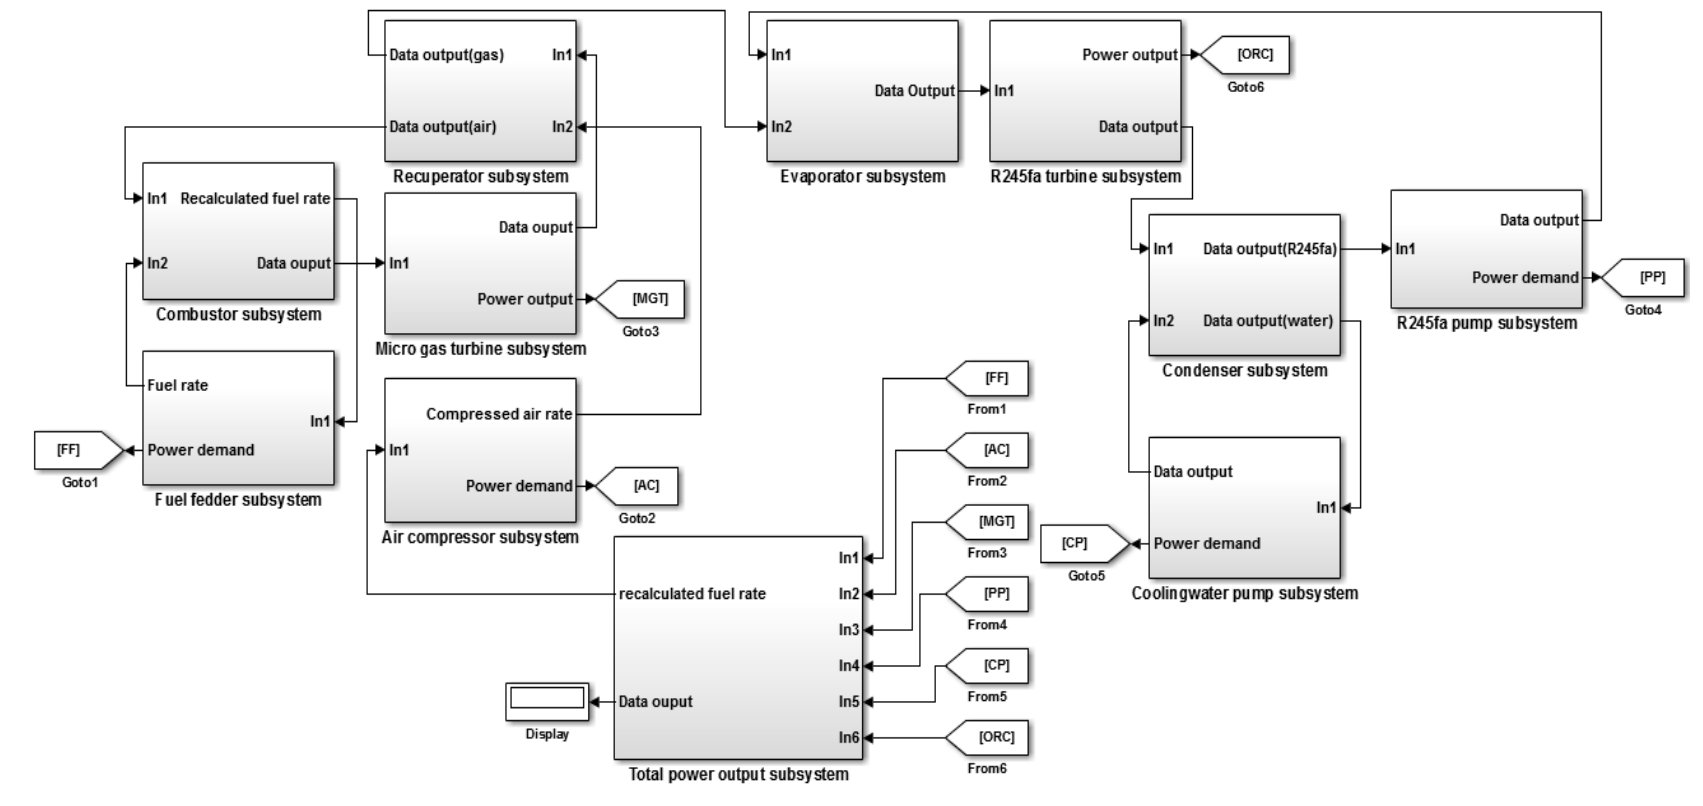
Figure 2. Matlab/Simulink blocks for the MGT/ORC hybrid power system.